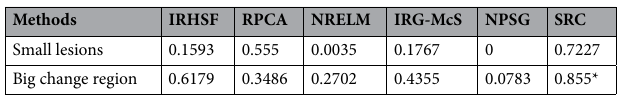
Table 1. Intersection over Union (IOU) of binary CMs for the image pair.